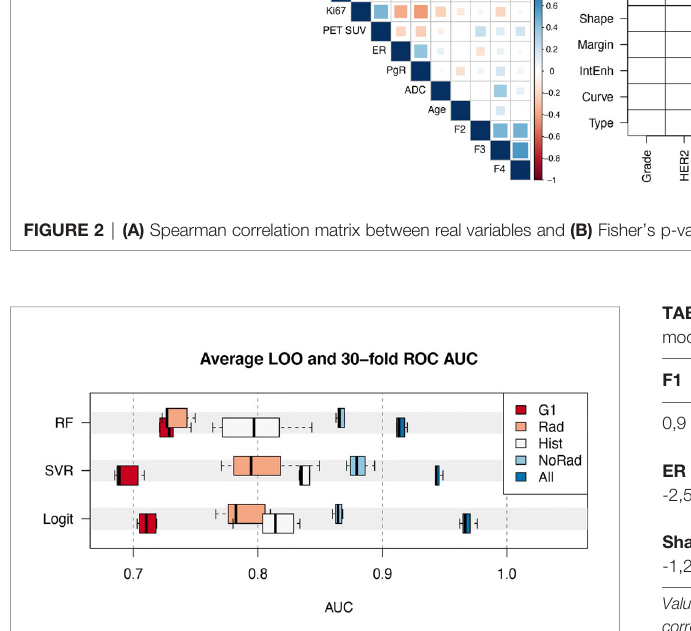
FIGURE 3 | Average AUC of the best 6 models as a function of the class of variables (G1, Rad, Hist, NoRad and All) and classi fi er (RF, random forest; SVR, Support Vector machines Regression; Logit, Logistic regression). Boxplots represent the median value, interquartile range and extremes.